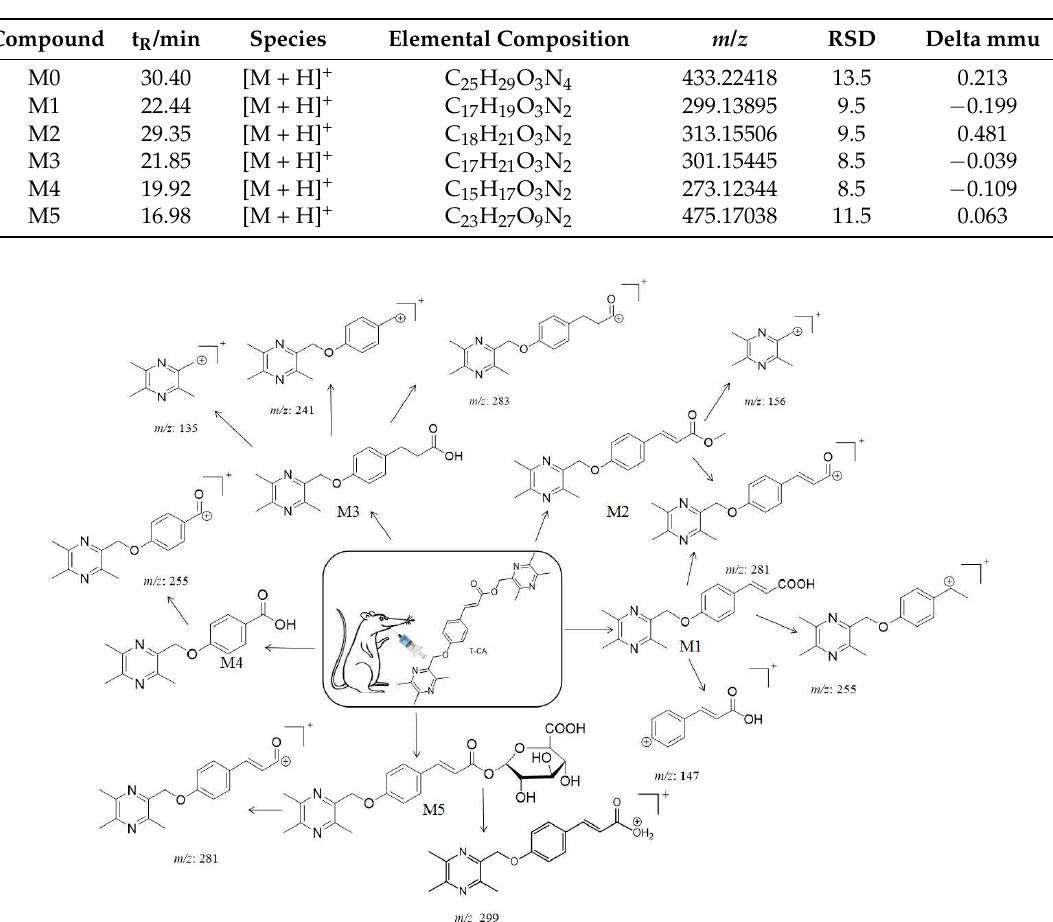
Figure 5. Proposed metabolic pathways of T-CA in